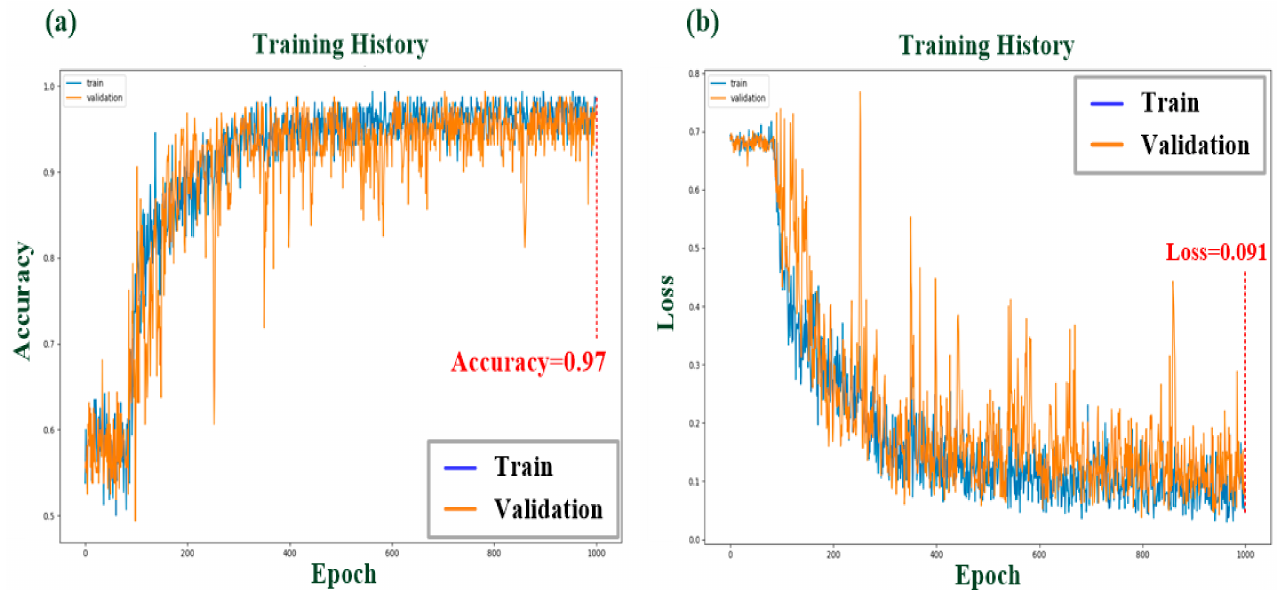
Figure 8. Training history curves for 2D fractional-order CNN-based classifier. ( a ) Training history of classifier’s accuracy for 1000 training epochs; ( b ) Training history of loss value for 1000 training